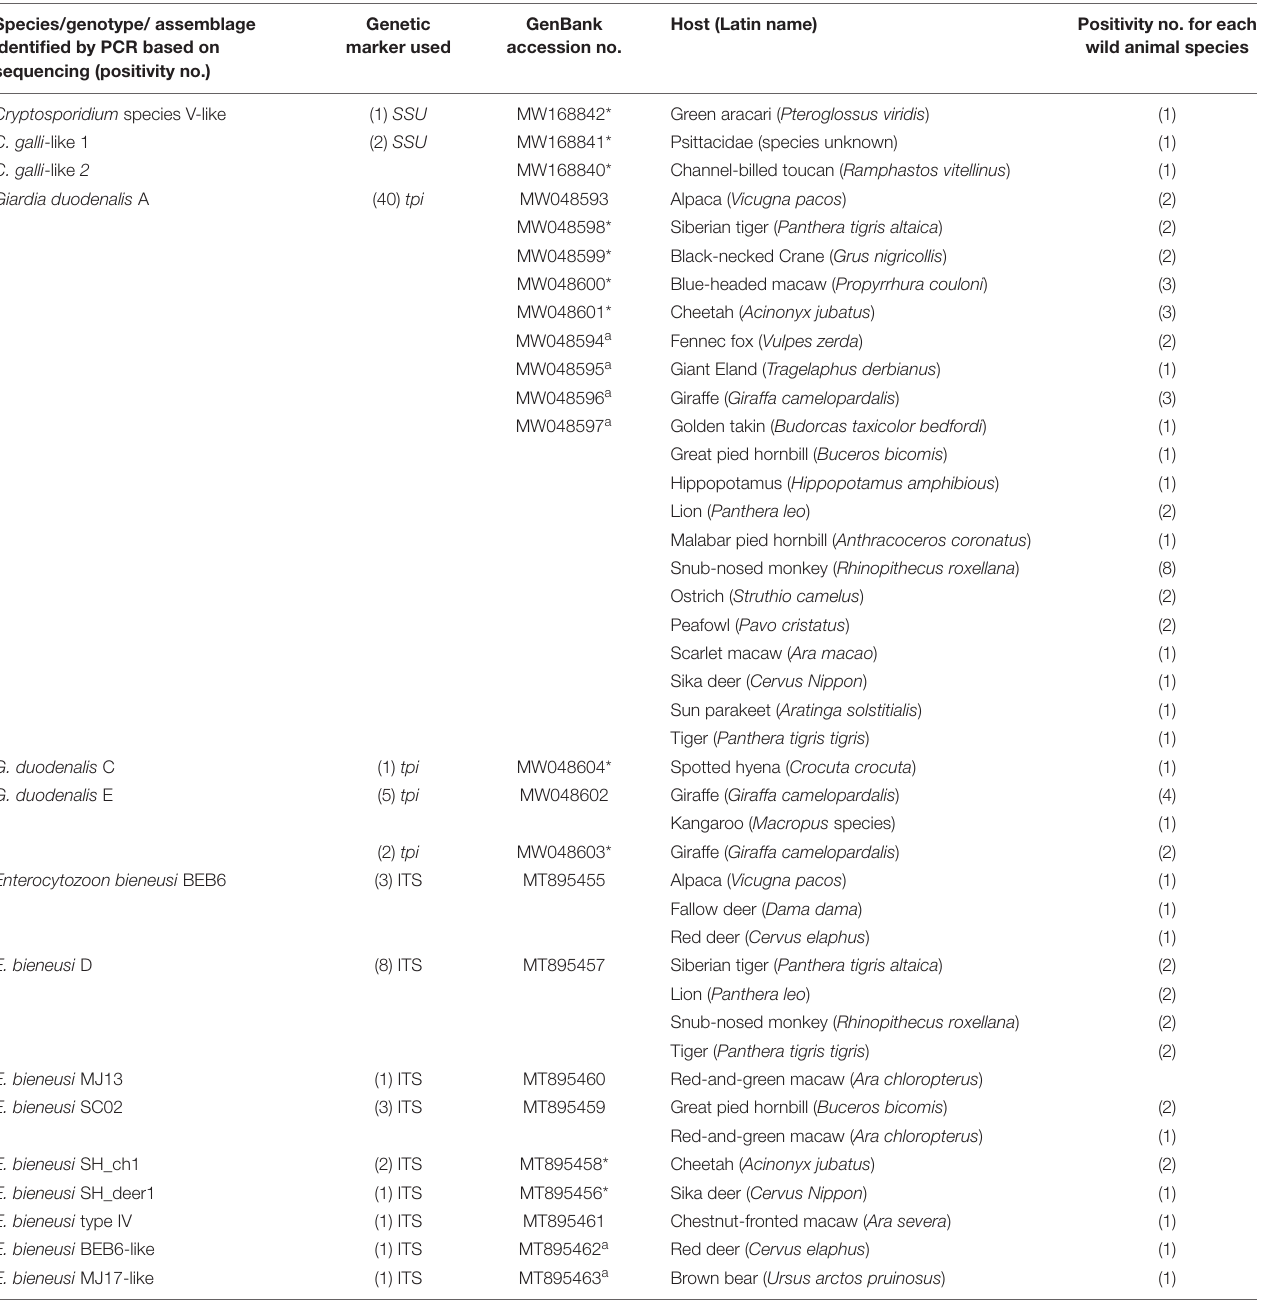
TABLE 3 | Summary of all pathogen species, genotypes, and/or assemblages identified in wildlife in Zhenjiang and Shanghai, China, using PCR-based sequencing of particular genetic markers. Species/genotype/ assemblage identified by PCR based on sequencing (positivity